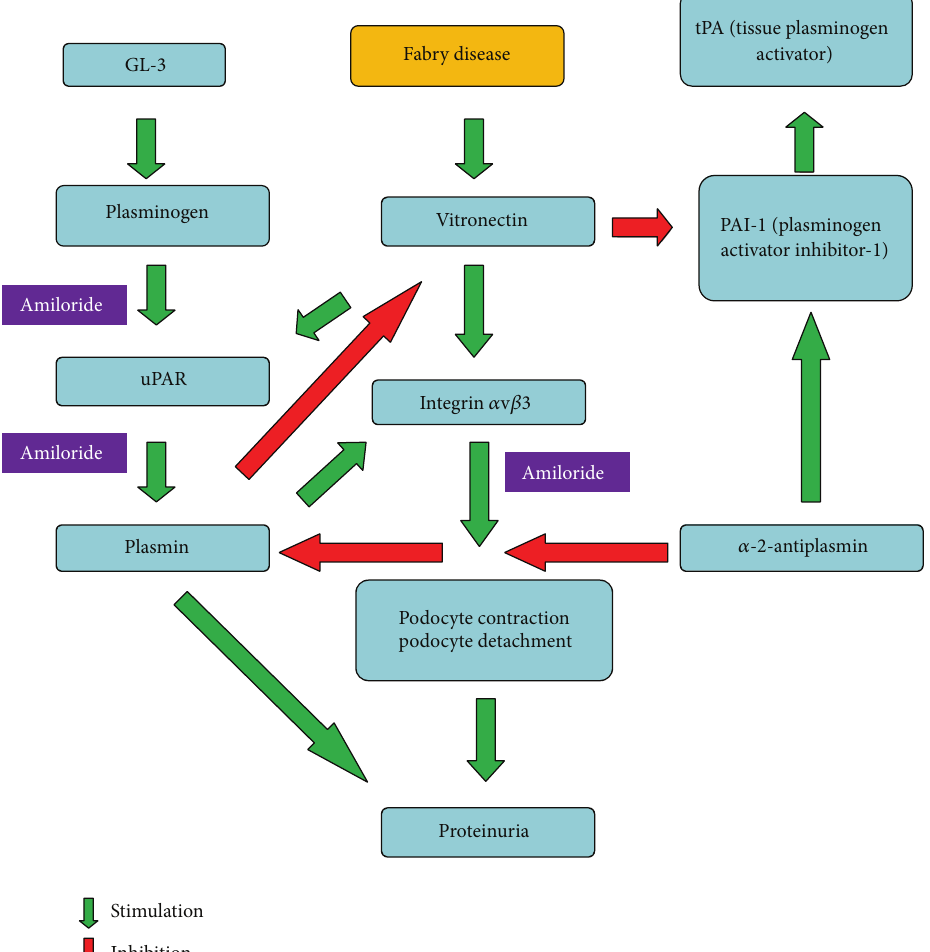
Figure 2: Interactions between globotriaosylceramide (GL-3), uPAR, plasminogen/plasmin, and integrin 𝛼 v 𝛽 3 and the development of proteinuria in Fabry disease, counteracted by